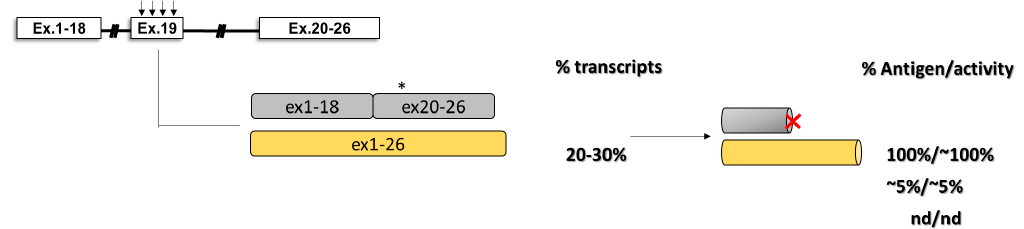
Figure 7. U1-mediated rescue in hemophilia A. Hemophilia A model caused by multiple nucleotide changes within the F8 exon 19. Schematic representation of the genomic context ( left panel), splicing transcripts ( middle panel) and protein isoforms ( right panel) is reported. Frameshift of the coding sequence and premature stop codons are reported by asterisks and red X letter, respectively. Percentages of transcripts, antigen and relative coagulation activity are shown on the right.